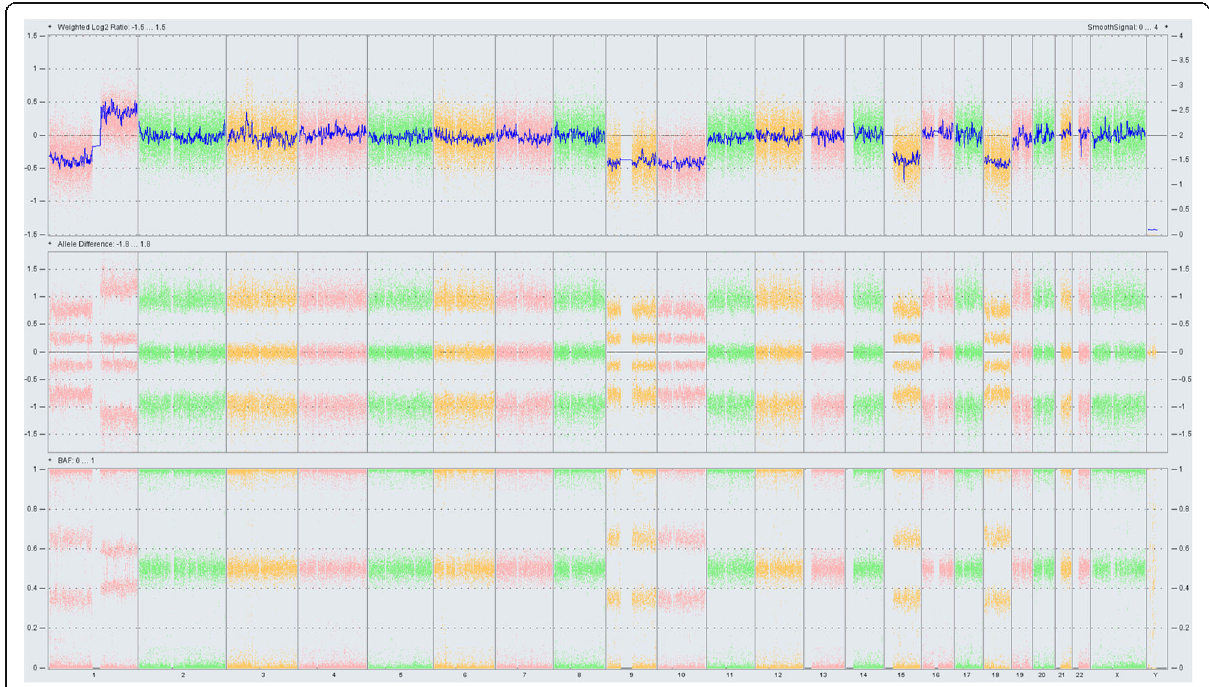
Fig. 3 Global chromosome copy number changes by Oncoscan analysis. Oncoscan analysis revealed copy number changes involving multiple chromosomes including losses of 1p, 9, 10, 15, 18 and, gain of